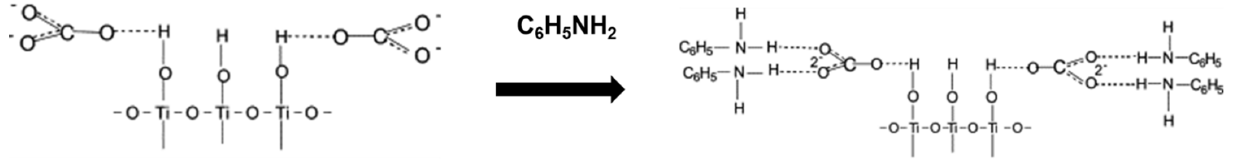
Figure 5. Adsorption of aniline on the surface of carbonate-modi fi ed TiO 2 .